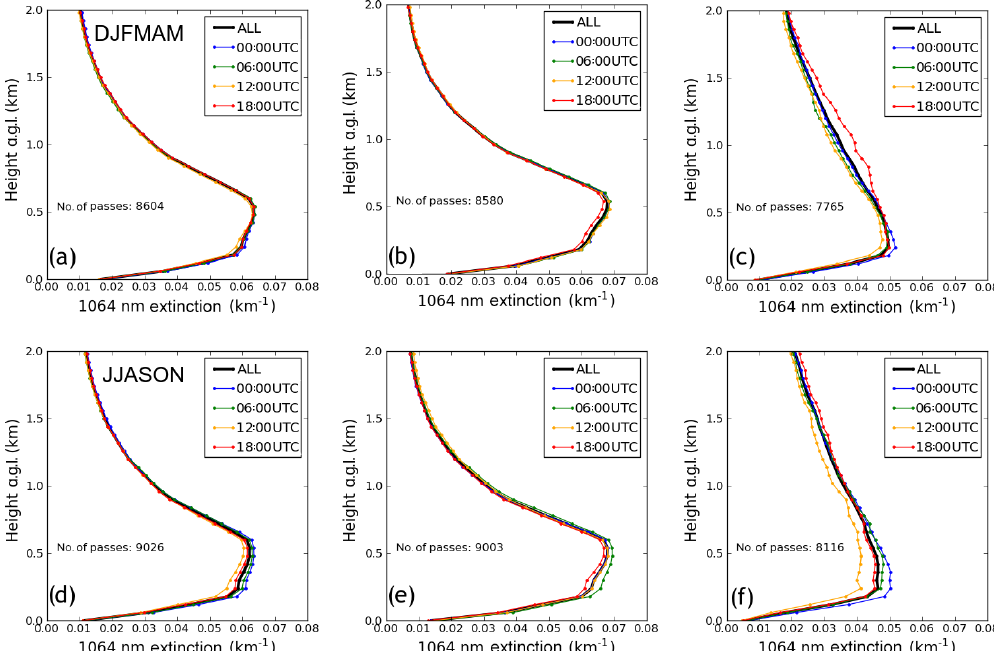
Figure 10. Global mean 6h vertical profiles of CATS 1064nm extinction for (a) all DJFMAM profiles, (b) DJFMAM water profiles, (c) DJFMAM non-water profiles, (d) all JJASON profiles, (e) JJASON water profiles and (f) JJASON non-water profiles. Mean AODs are as follows: (a) 0.084, (b) 0.078, (c) 0.098, (d) 0.089, (e) 0.082 and (f) 0.102.